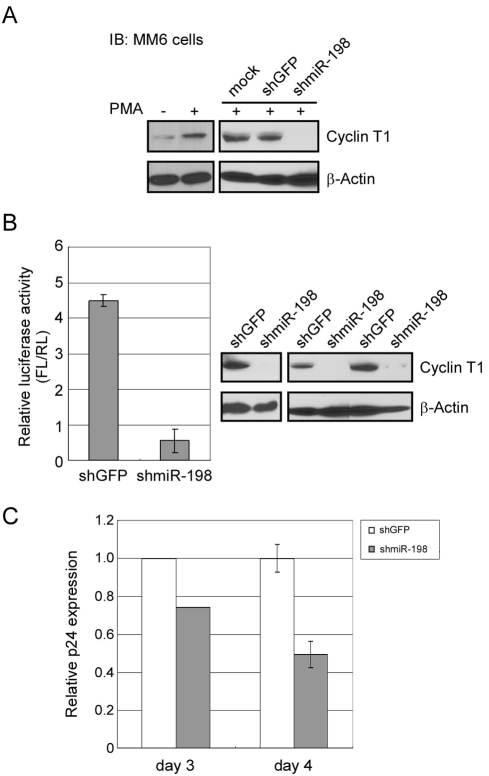
Down-regulation of Cyclin T1 by miR-198 inhibits HIV-1 proviral gene expression and HIV-1 replication.(A) Left panel: Immunoblot analysis of Cyclin T1 levels in MM6 cells treated with or without PMA for 48 hours. Right panel: MM6 cells were mock-transfected or transfected with shGFP- or shmiR-198-expressing plasmids and then treated with PMA. Cells were harvested 48 hours after PMA treatment and examined for Cyclin T1 expression. β-actin expression was analyzed as a loading control. (B) A HIV-1 NL4-3 firefly luciferase proviral reporter plasmid was co-transfected with shGFP- or shmiR-198-expression plasmids and a renilla luciferase reporter internal control plasmid into MM6 cells. Cells were treated with PMA immediately after transfection, and cell extracts were prepared 48 hours later and divided into two equal portions for dual-luciferase assays and immunoblot analyses. Relative luciferase activity was determined by normalizing firefly luciferase activity to renilla luciferase activity. Two independent transfection experiments were performed; in one experiment transfections were performed in duplicate. For immunoblots to examine Cyclin T1 expression, panel on left represents the single transfection experiment, while panel on right represents the duplicate transfection experiment. Luciferase assays shown are the average of the three transfections with bars representing the range in the three measurements. C. MM6 cells were transfected with shGFP- or shmiR-198-expression plasmids in two independent experiments. Cultures were treated with PMA immediately after transfection and one day later were infected with HIV-1 strain SF162. Expression of p24 in culture supernatants was measured at three days post-infection in experiment 1 and at four days post-infection in experiment 2. The data in experiment 2 show the means±SD of infections carried out in triplicate in the control (shGFP) or shmiR-198 plasmid.